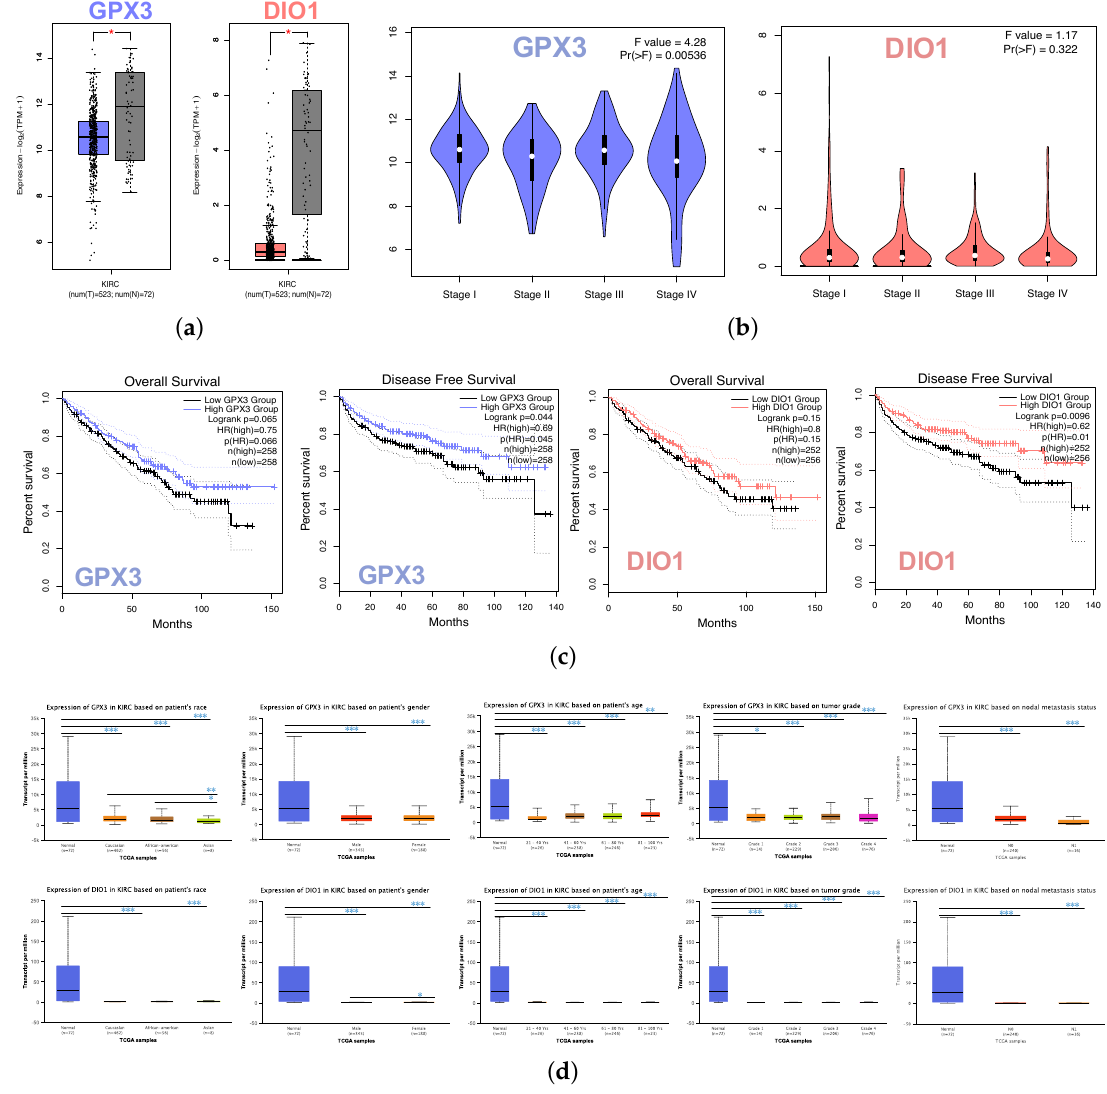
Figure 2. Identifications of significant KIRC-related selenoproteins. ( a ) Different expression of GPX3 and DIO1 in KIRC samples and healthy samples by box plot. tumor group (T), normal group (N). p value < 0.05. ( b ) Correlation between GPX3 and DIO1 expression and KIRC tumor stage in the violin plot. The expression of GPX3 was significantly downregulated in Stage IV. Pr ( > F ) = 0.00536. ( c ) KIRC cases were divided into two groups based on their individual expression levels. As shown in the Kaplan–Meier survival curve, median disease free survival of the high expression groups is longer than the low expression group significantly, as indicated by the log-rank test, p value < 0.05. However, the median overall survival is not statistically different as indicated by the log-rank test, p value > 0.05. ( d ) Box plots showing relative transcription of GPX3 and DIO1 in subgroups of KIRC patients, stratified based on gender, age, race, tumor grade, and metastasis status. Data are mean ± SE. * p < 0.05; ** p < 0.01; *** p <